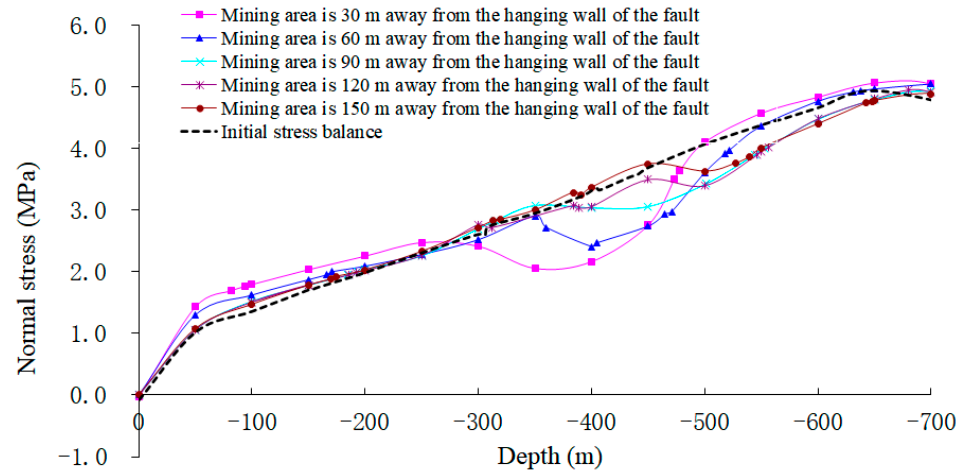
Figure 7. When the mining area is situated within the fault hanging wall, the normal stress distribu- tion on the fault plane is at various locations.